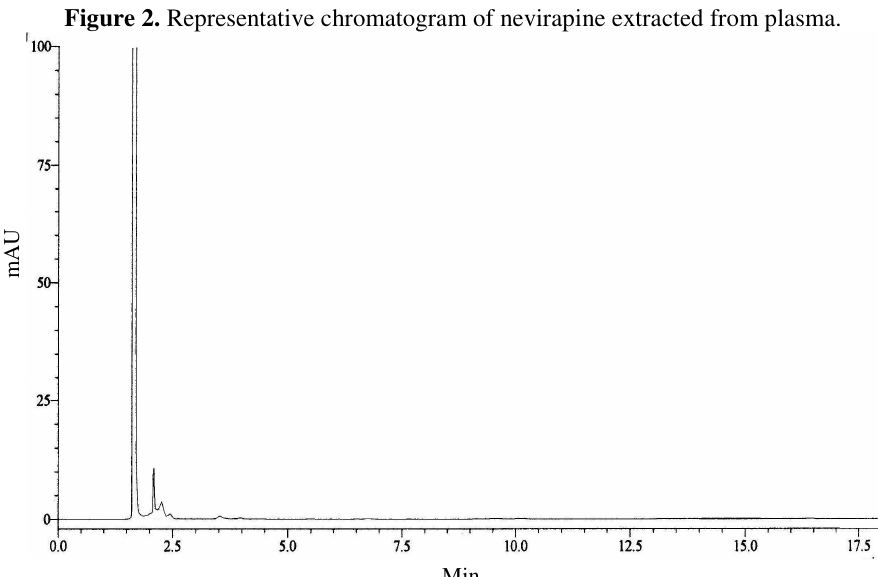
Figure 3. Representative chromatogram of extracted blank plasma